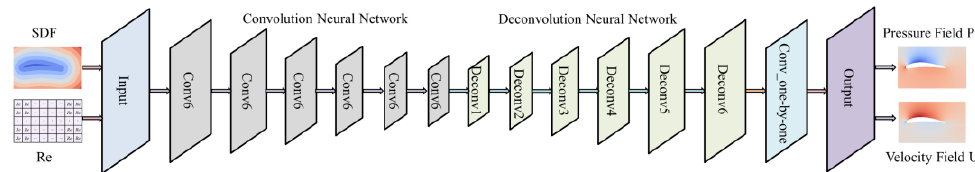
Figure 2. Specific architecture of flow field prediction network. “Conv” denotes convolutional layer, “Deconv” indicates deconvolutional layer, “Conv_one-by-one” refers to the one-by-one convolutional layer.